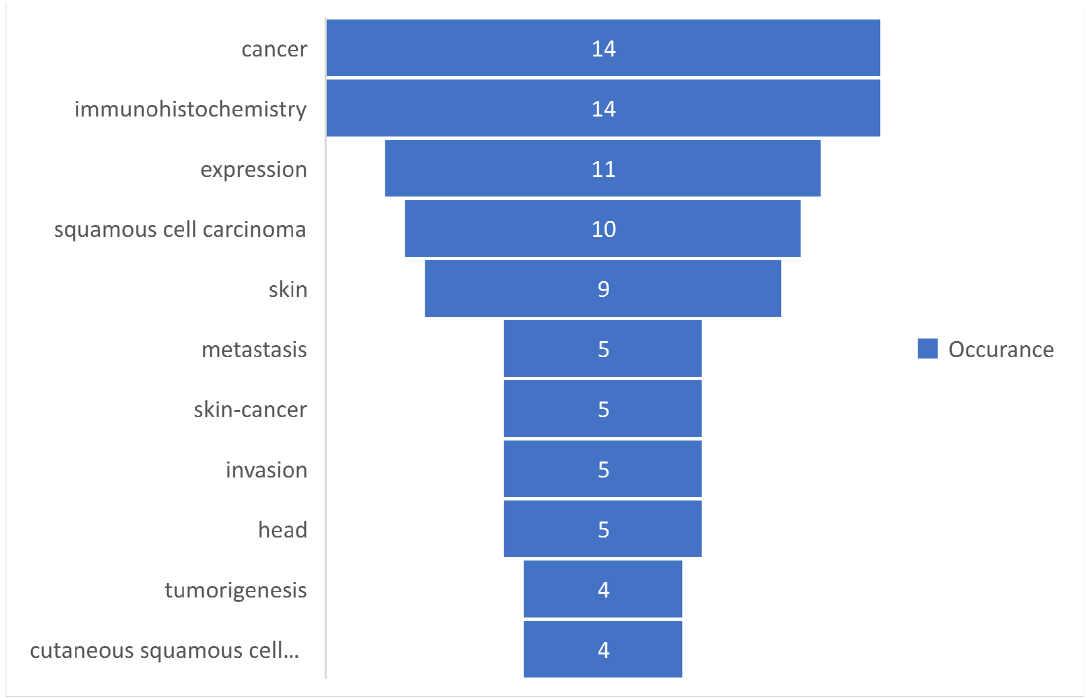
Figure 5. The most commonly used keywords based on occurrences.